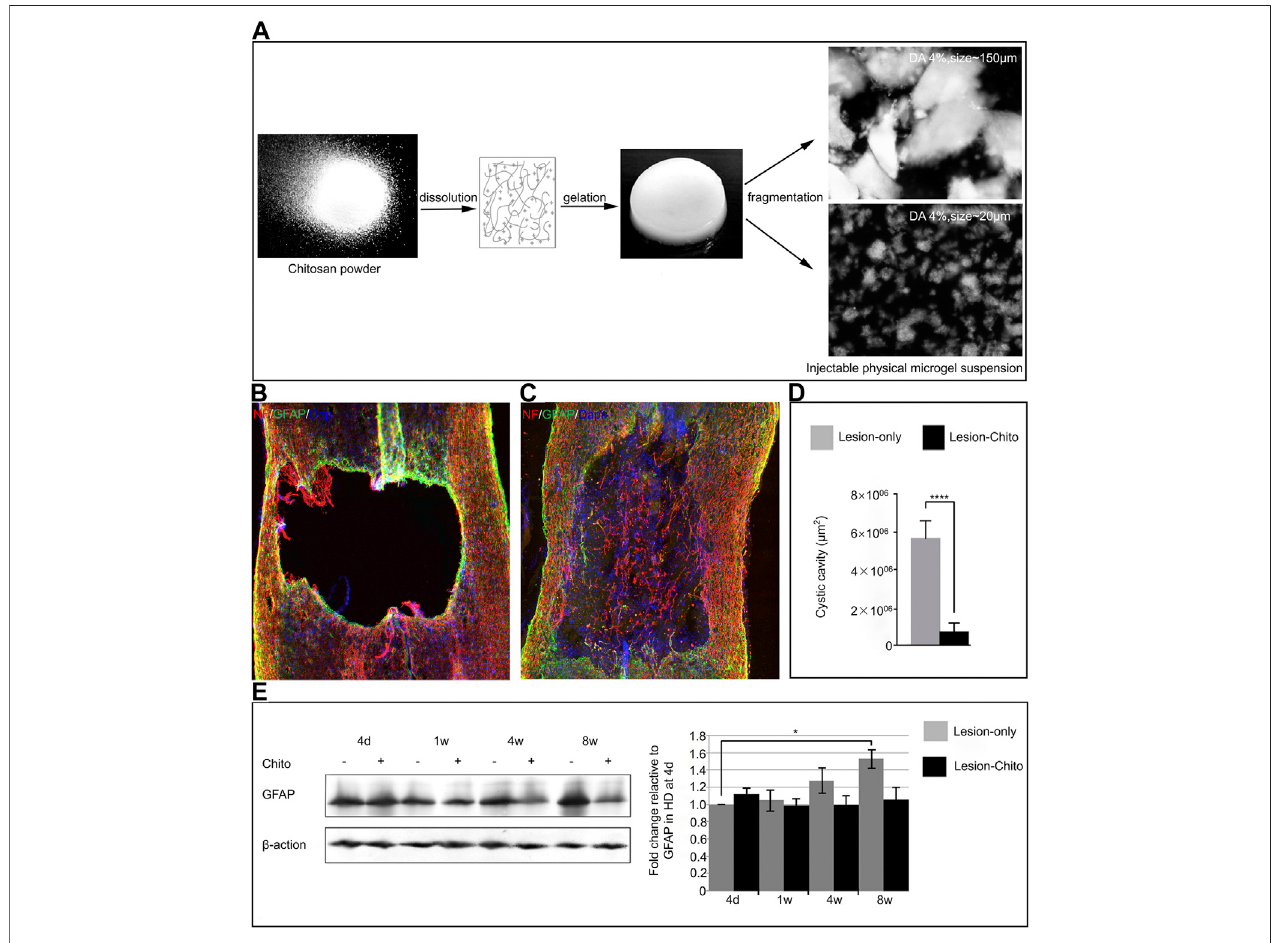
FIGURE 4 | Regulation of astrocytes by biomaterials. (A) Preparation of chitosan-FPHS. (B,C) Immuno fl uorescence staining was performed in the control group andthetreatmentgroup4weeksaftersurgery. (D) Comparisonofprimarylesionareabetweenthetreatmentgroupandthecontrolgroup. (E) Westernblotwasusedto analyze GFAP levels in the treatment group and the control group at different time points after surgery. Reproduced with permission from (56).